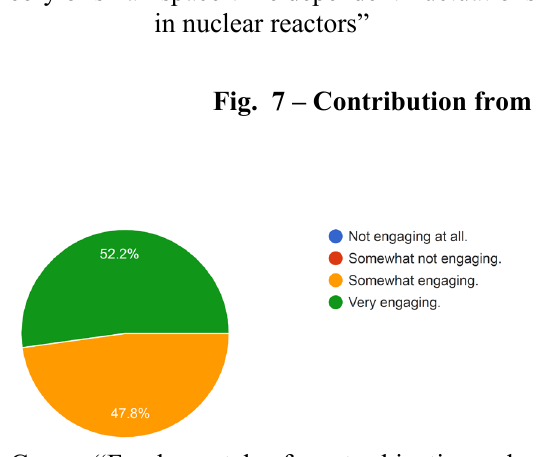
Fig. 8 – Engagement in the synchronous